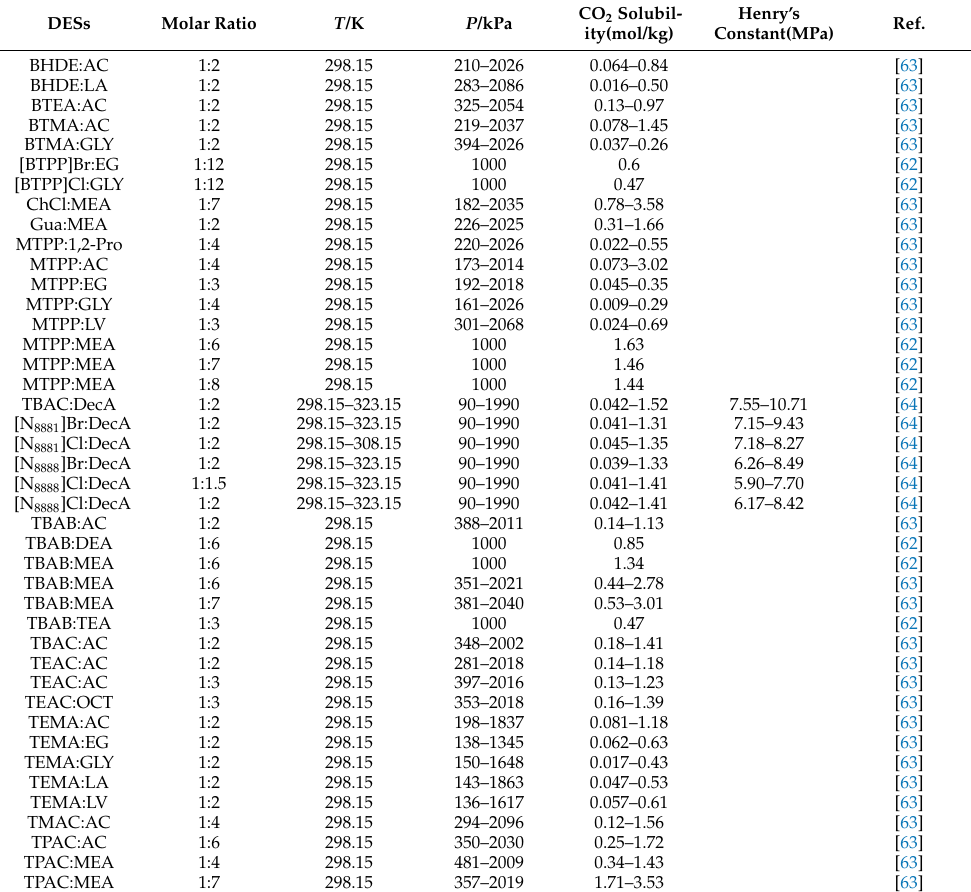
Table 3. CO 2 solubility and Henry’s constant in physical-based